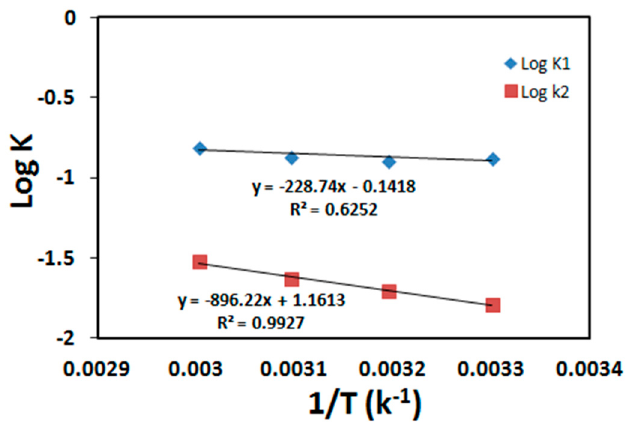
Figure 14. Variation of log k 1 and log k 2 with 1 / T for sorption of Th(IV) onto HQ-bentonite (Arrhenius plot).